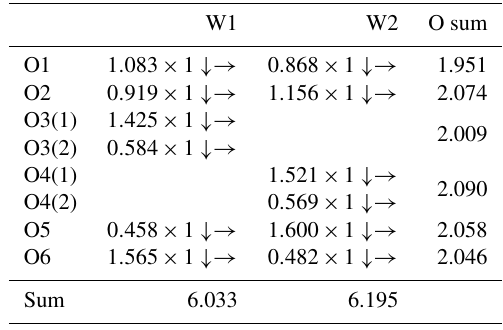
Table 5. Bond-valence sum for liguowuite. W1 W2